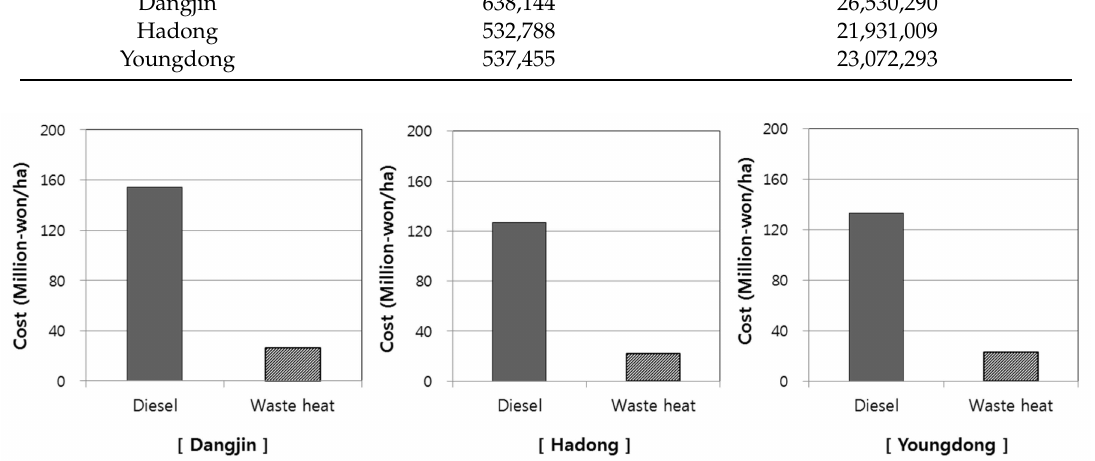
Figure 10. Comparison of operation costs in each